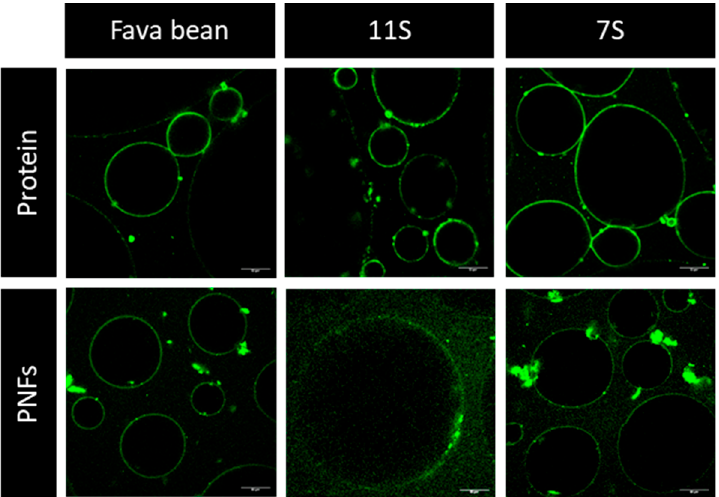
Figure 7. Confocal images (staining with thioflavin T fluorescent dye) of bubbles stabilised by non- fibrillated (protein) and fibrillated (protein nanofibrils, PNFs) proteins from fava bean and its globular fractions 7S and 11S. Scale bar 50 μ m.